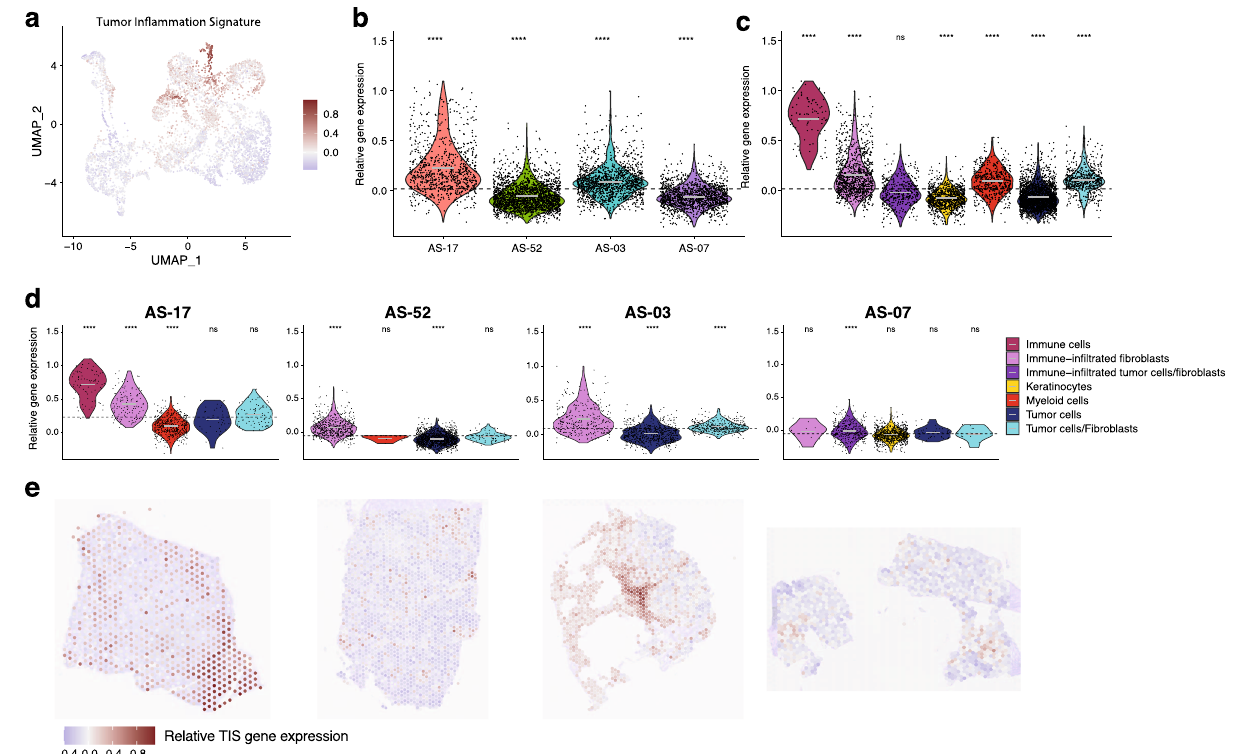
Fig. 6 Spatial projections of the Tumor In fl ammation Signature (TIS) in head and neck angiosarcoma. a UMAPplot ofspot transcriptomeclustersshowing relativeaverageexpression ofgenesinforming theTISscore.Violinplots showing relativeaverageexpressionof TIS genes across ( b ) thefour samplesand( c ) the clusters annotated by their predominant cell types. d Immune cells from AS-17 exhibited the highest average expression of TIS genes, followed by immune- in fi ltrated fi broblasts in AS-17, AS-03 and AS-52, as well as immune-in fi ltrated tumor cells/ fi broblasts in AS-07. The myeloid cells had the lowest TIS gene expression in AS-17. The dotted horizontal line represents the mean TIS genes expression of a sample, while the gray line in each violin represents the mean